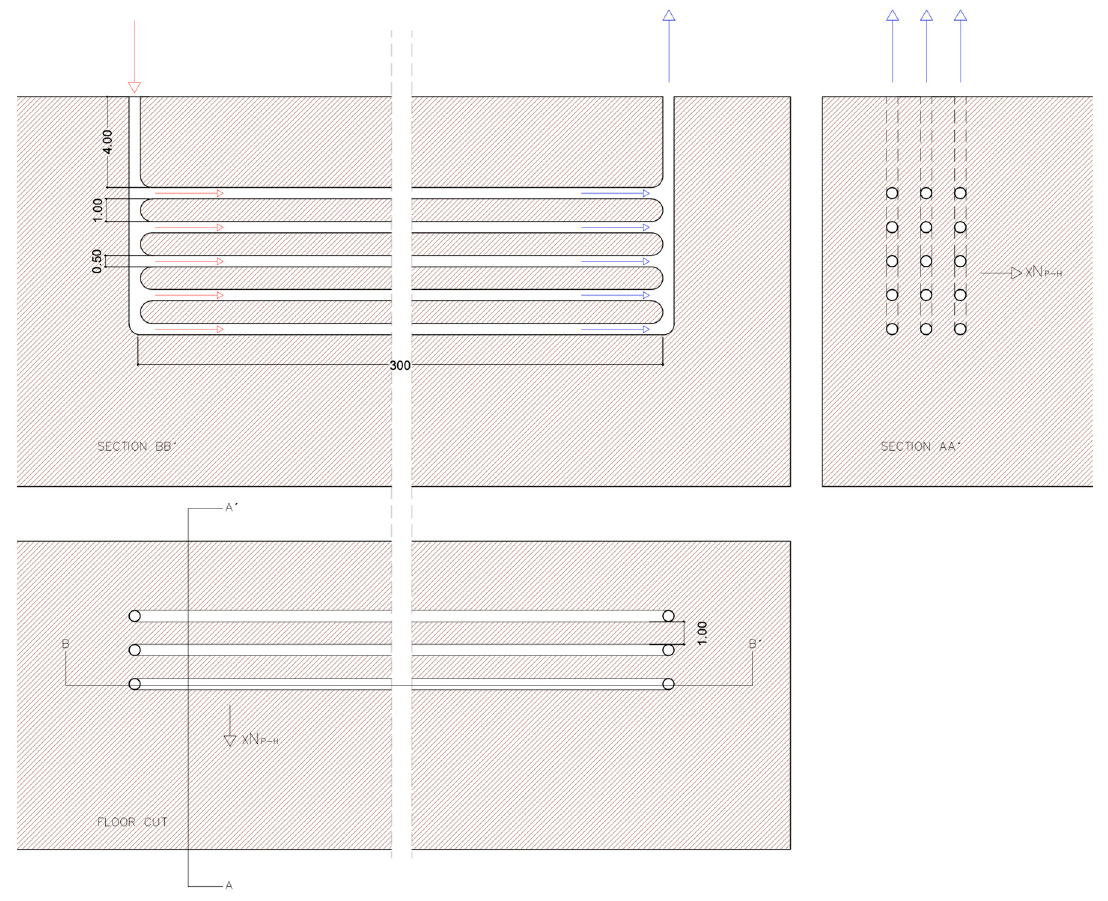
Figure 8. Sketch of the piping arrangement.